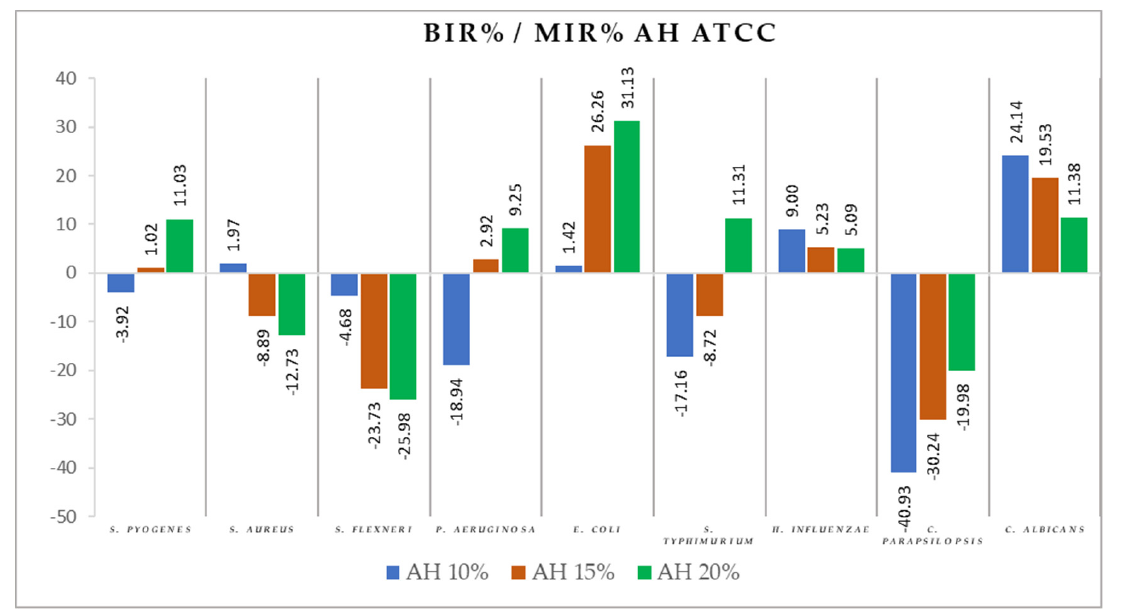
Figure 6. AH antimicrobial activity (expressed as BIR%/MIR%) on ATCC strains.